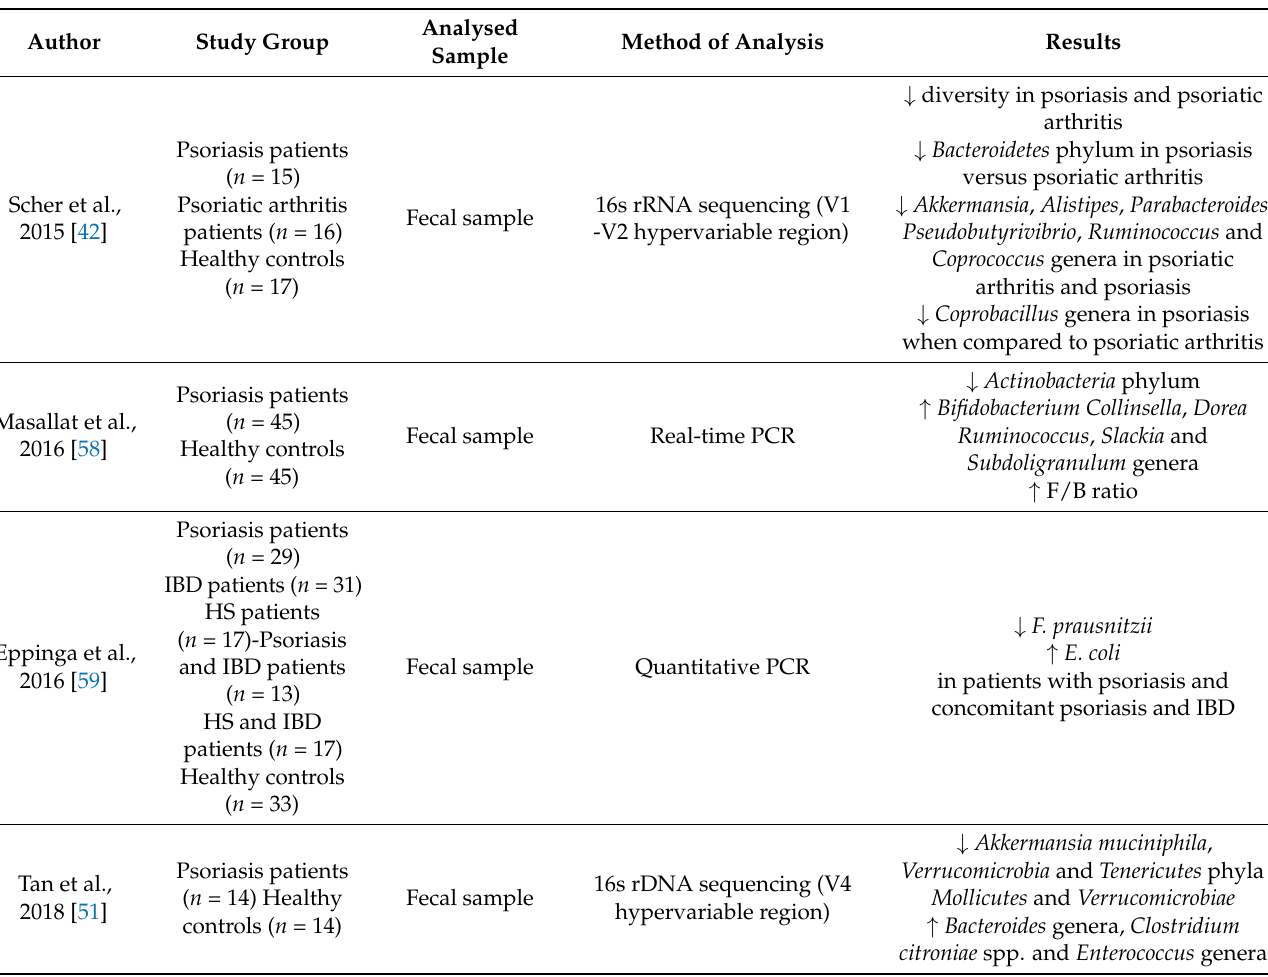
Table 2. Summary of the most relevant research studies on the gut microbiome of patients with